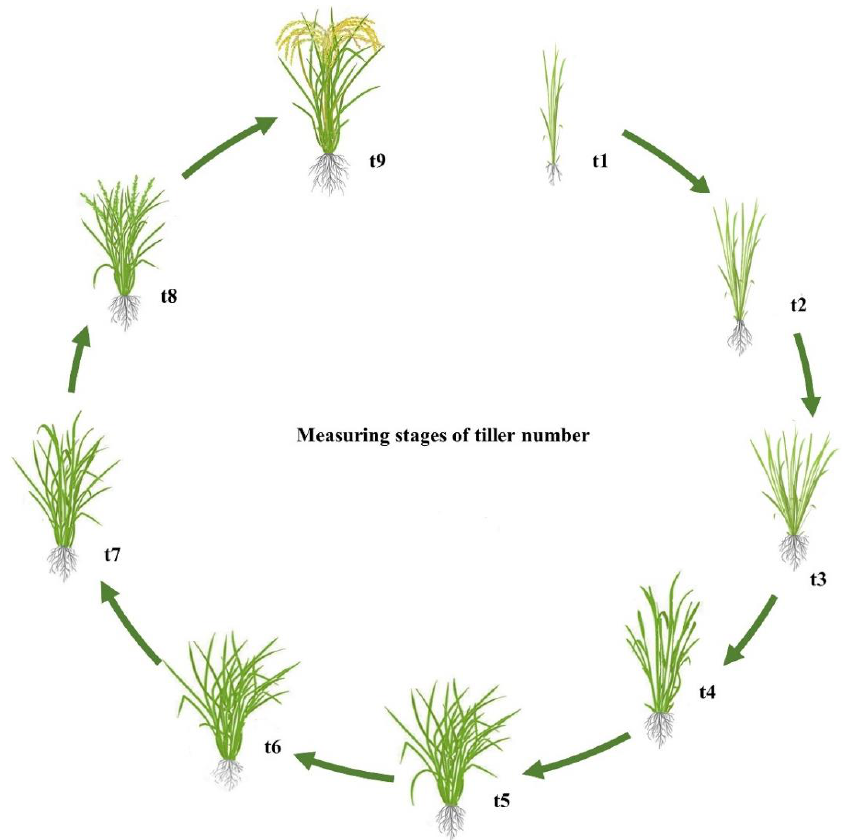
Figure 1. Tiller number measuring stages. The tiller number of each plant was investigated every 7 days, starting 30 days after planting the seedling into the field (stages are denoted as t1 to t9).